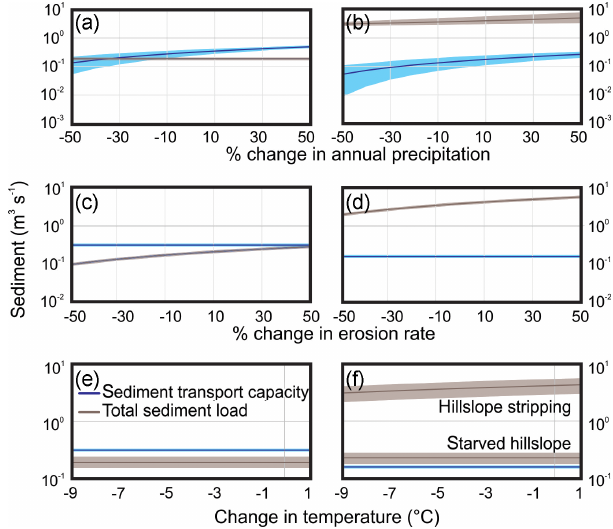
Figure 9. Response of sediment transport capacity (blue lines) and total sediment load (brown lines) to changes in annual precipita- tion (a, b) , erosion rate (c, d) , and temperature (e, f) for nodes on the plateau 30km downstream (a, c, e) and beyond the knickzone 100km downstream (b, d, f) . Each variable was changed within the estimated range for glacial–interglacial fluctuations (Baker et al., 2001; Garaud et al., 2003). The uncertainty for precipitation re- sponse (a, b) is propagated from the modern variability (Agteca, 2010; Fig. 7). We assume an average 10% uncertainty in erosion rates (c, d) derived from cosmogenic nuclides and a 30% uncer- tainty in temperature (e, f) reflecting large uncertainties in the lapse rate. In all cases, the long-term variability does not likely change our model results. The exception to this is that sediment transport capacity on the plateau can drop below the sediment load at very low annual precipitation (a) or very fast erosion (c)